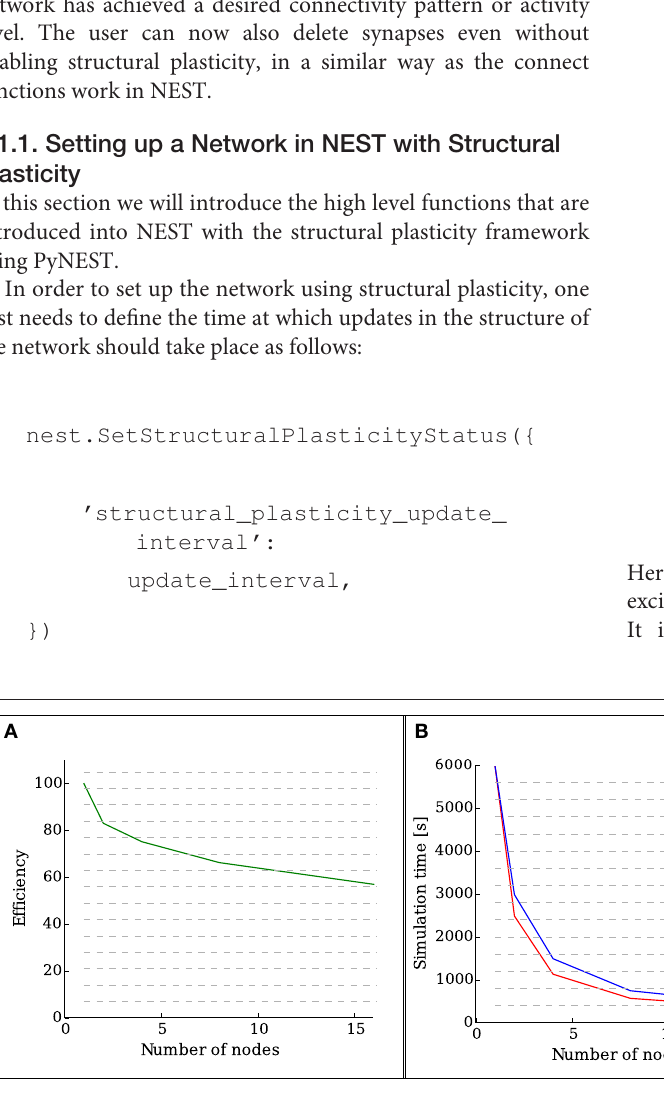
FIGURE 4 | Results of the scalability tests performed with structural plasticity. (A) Efficiency as a function of the number of nodes for 5000 neurons in the weak scaling test. The network was allowed to grow synapses following the structural plasticity rules during a simulation of 100s of biological time. (B) Simulation time (red curve) as a function of the number of nodes for a network of 100 , 000 neurons and in the strong scaling test. The blue curve indicates ideal linear scaling. (C) Efficiency as a function of the number of nodes for a network of 100 , 000 neurons in the strong scaling test. The peak scaling efficiency is marked with a star.